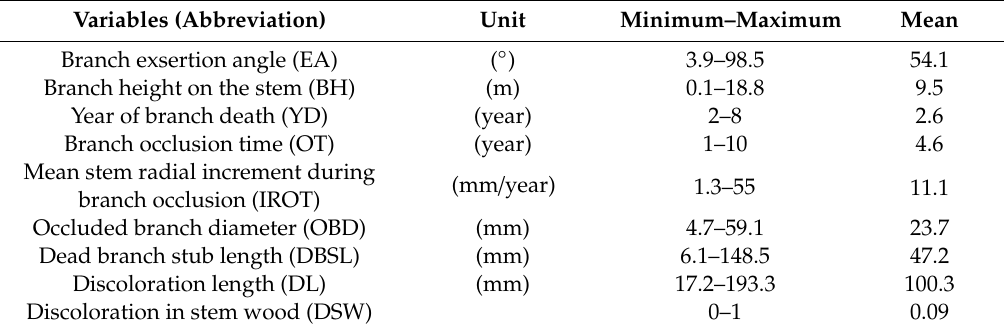
Table 3. Summary individual-branch